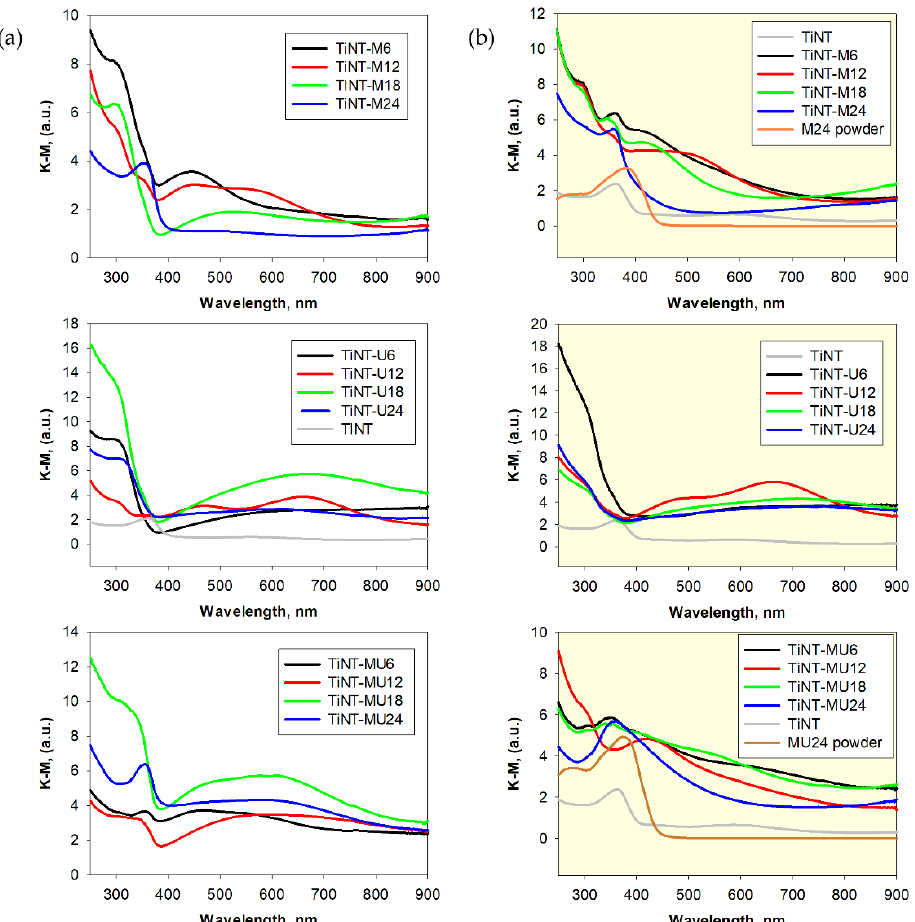
Figure 6. UV-vis spectra of TiNT reference, pure g-C 3 N 4 (from M 24 and UM 24 powders), and TiNT composites derived from melamine (M), urea (U), and (MU) precursor. Spectra recorded for: ( a ) the front side of each sample not facing the crucible and ( b ) the back side of each sample facing the inside of the crucible containing the precursor [38].